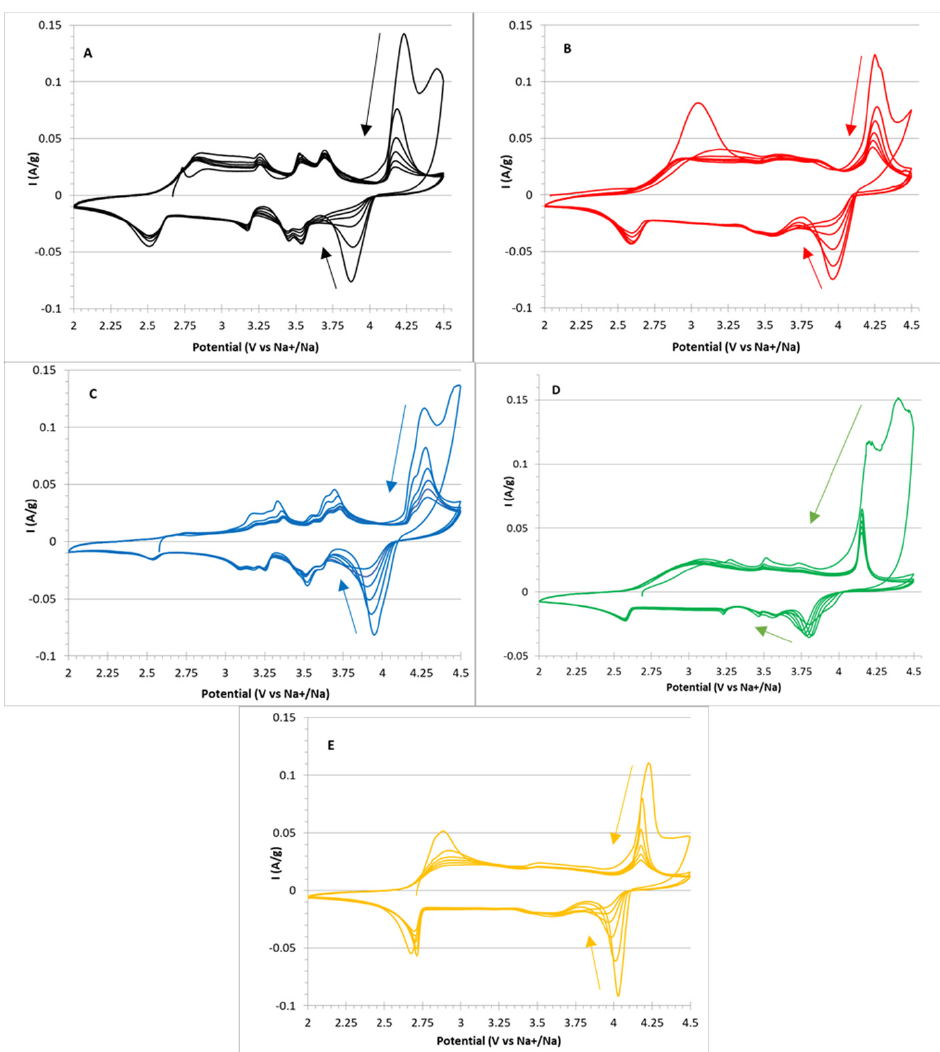
Figure 5. Cyclic voltammetry cycles in the 2–4.5 V potential window for ( A ) NMNO, ( B ) NMNO–Ti, ( C ) NMNO–V, ( D ) NMNO–Cu, and ( E ) NMNO–Ti-def samples. The arrows indicate the progression of cycles.